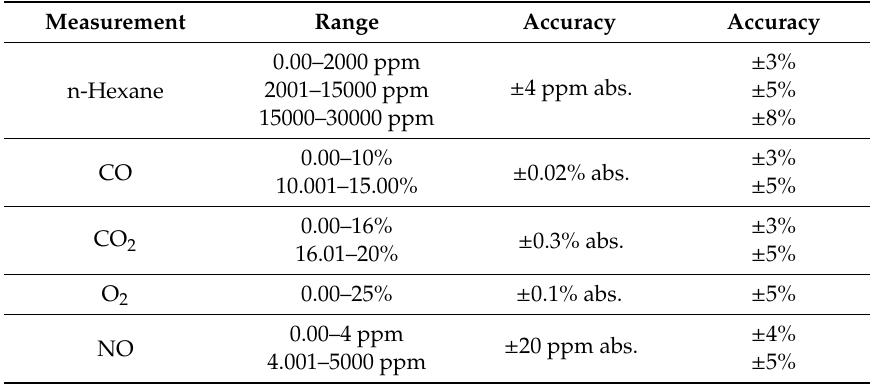
Table 3. CODA gas analyser